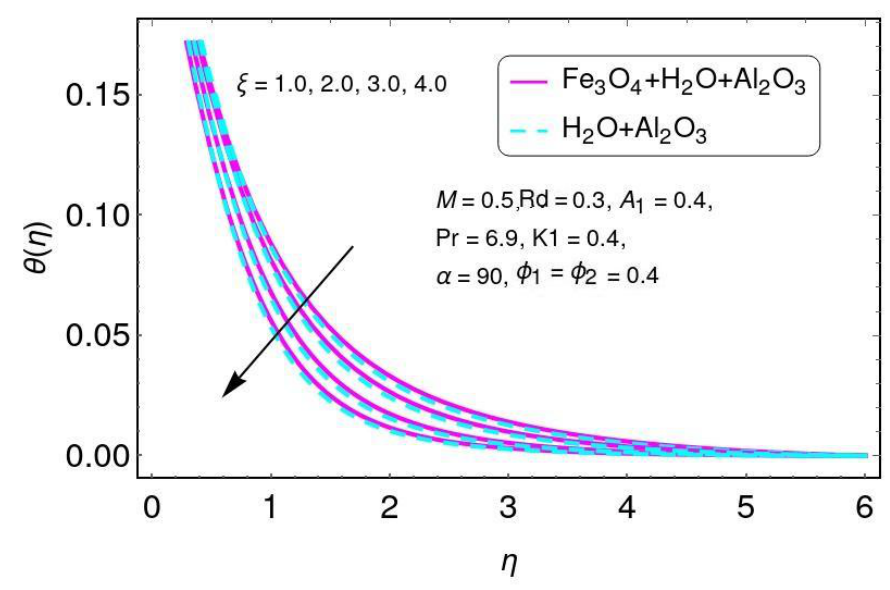
Figure 5. Temperature field for ξ